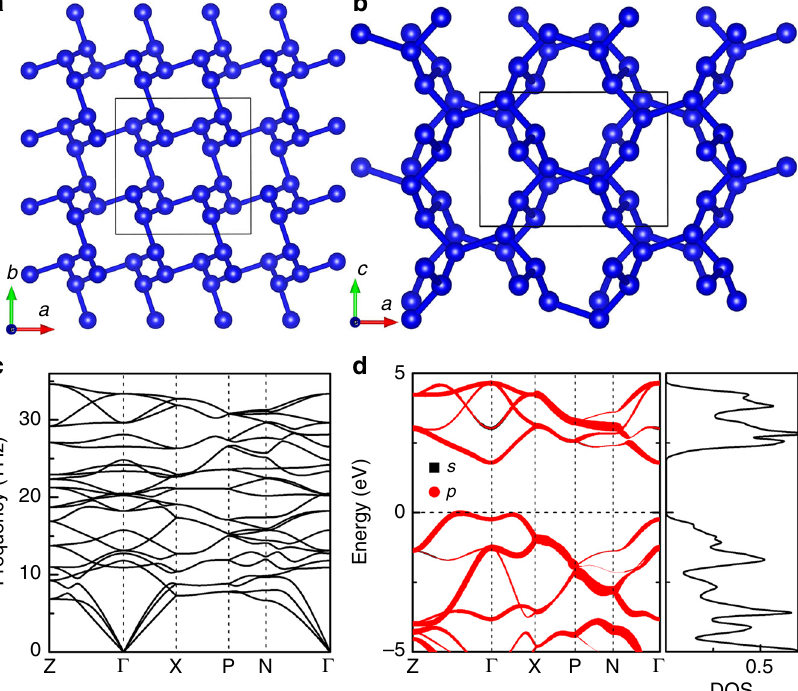
Fig. 4 Crystal structure, phonon dispersion and electronic band structure of t-N. a Crystal structure of t-N viewed along c -axis and b b -axis. c and d are phonon dispersions and electronic band structure of t -N at ambient pressure, respectively